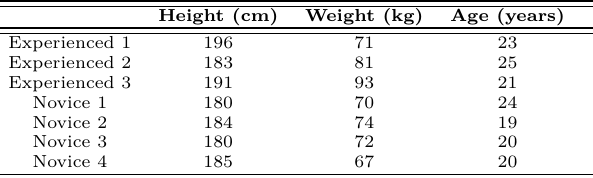
Table 1: Experiment subject characteristics